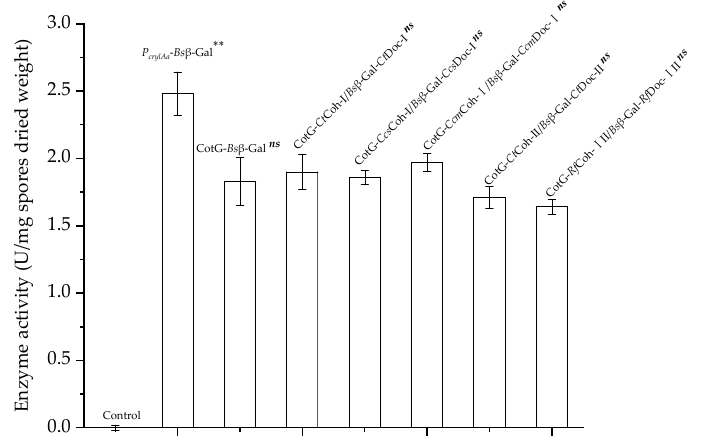
Figure 4. Comparison between the enzyme activities of different spore-displayed Bs β –Gals. Control, wild type B. subtilis WB600 spores. The values are the means obtained from triplicated experiments. Error bars represent standard deviations. Comparison of data among groups was performed one-way ANOVA with Tukey’s post-hoc test. ** denotes significant difference between P cry1Aa – Bs β –Gal and other six groups ( p < 0.05); ns indicates no significant differences between any two of those